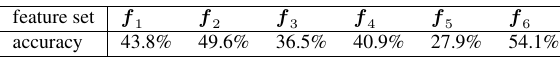
Table 4: Average accuracy of RDF classifier on each feature set of eTRIMS 8-class